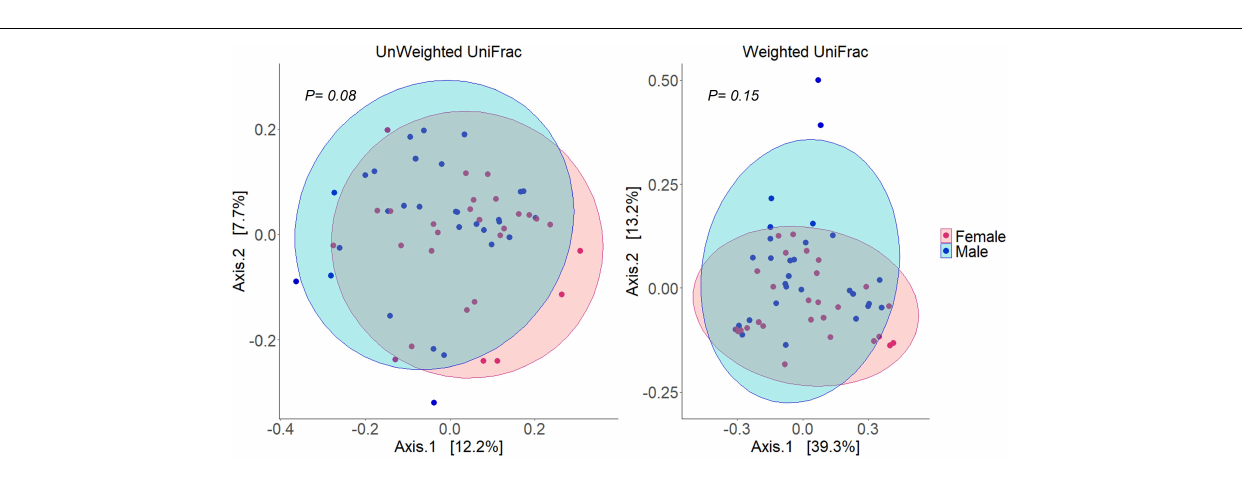
compared to males. Saccharibacteria was also abundant (10-fold) in females compared to